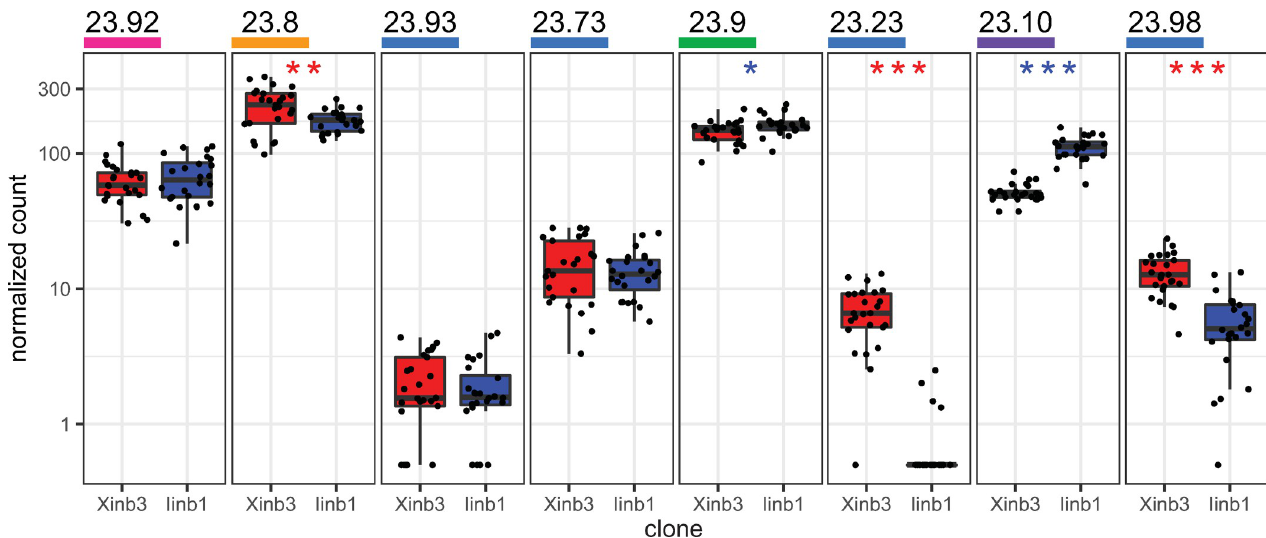
Fig 4. Differential gene expression of shared genes between QTL parent clones. Boxplots showing gene expression data collected for a previous study [30], with raw RNA-seq reads from QTL parent clones Xinb3 and Iinb1 mapped to the genome-based transcriptome from clone Xinb3. Gene names are underlined with colors corresponding to functional annotation (see Fig 1). Y-axes from each plot show normalized read counts with a pseudocount of 0.5 added to allow for log-scale plotting. Each plotted point represents a Daphnia magna individual from the respective clone. Box edges indicate first and third quartiles, central line indicates median, and whiskers extend to 1.5 x interquartile range. Asterisks indicate genes that show significant differential expression (non-zero logarithmic fold change in mean expression across all treatments combined) between QTL parent clones Xinb3 (n = 25) and Iinb1(n = 24), with clone Xinb3 as reference after correcting for multiple tests: Benjamini-Hochberg-adjusted p-value < 0.05 ( � ), < 0.01 ( �� ), < 0.001 ( ��� ). Asterisks are colored according to the parent clone which shows higher expression (red = susceptible parent Xinb3; blue = resistant parent Iinb1). Wald test statistics and Benjamini-Hochberg- adjusted p-values are as follows: 23.92: z = 0.425, p = 0.498; 23.8: z = -2.78, p = 9.96E-03; 23.93: z = -0.488, p = 0.690; 23.73: z = -0.898, p = 0.442; 23.9 z = 2.59, p = 0.0167; 23.23 z = -8.89, p = 4.00E-18; 23.10 z = 13.23, p = 8.51e-39; 23.98 z = -6.23, p = 1.80E-09. For the same expression data presented separately for each treatment condition, see S6